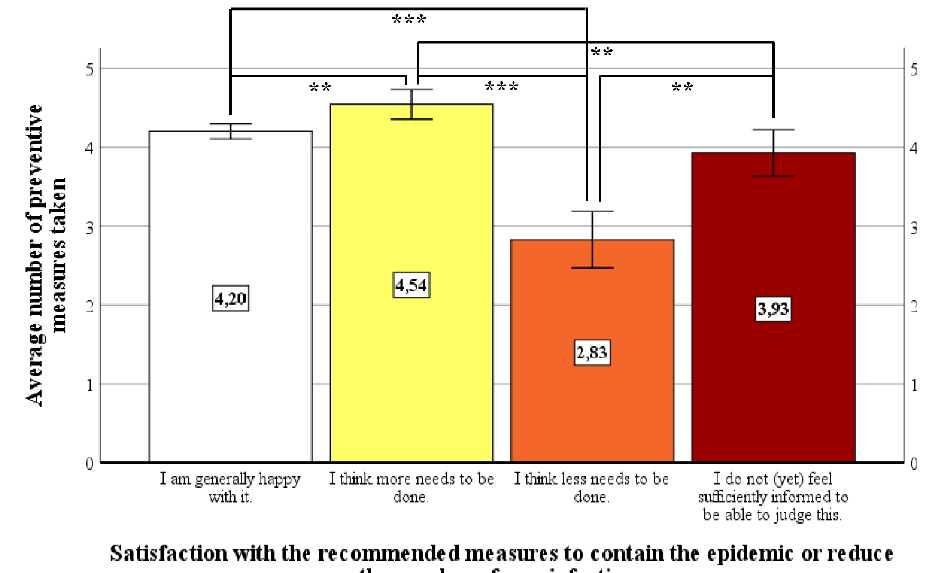
Figure 4. Differences in prevention behavior depending on satisfaction with the national recommended/statutory preventive measures (** = p < 0.01, *** = p <